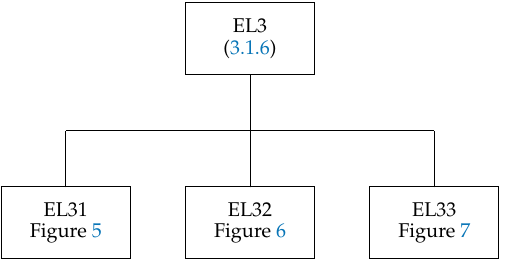
Figure 4. Global structure of the subroutine EL3